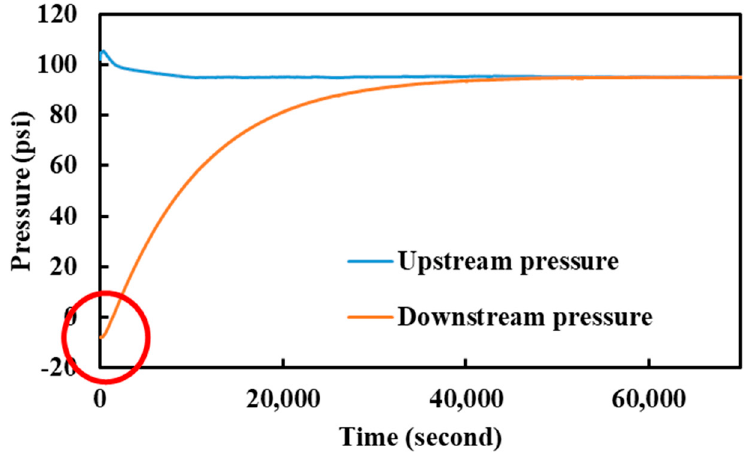
Figure 10. Constant pressure gas injection to form gas saturation in the pulse-decay set-up.